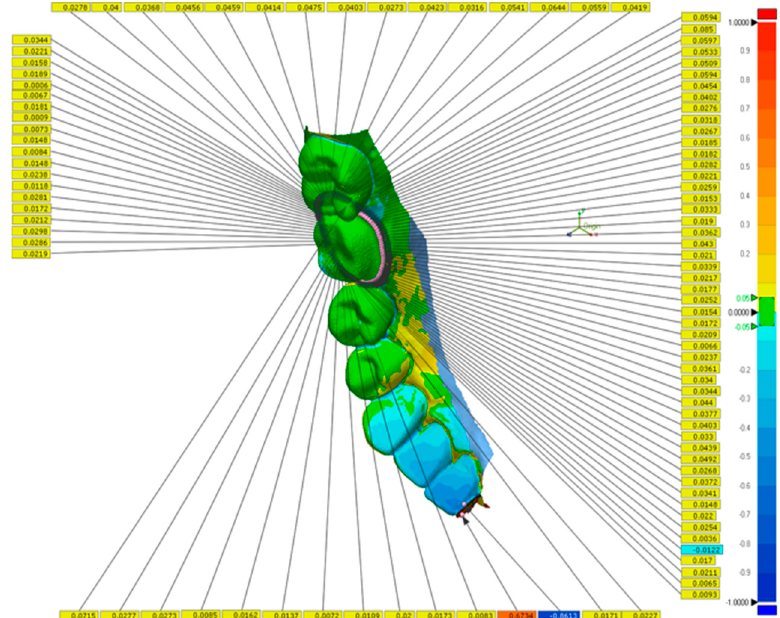
Figure 3. Deviation between master scan and intraoral scan measured at 100 evenly spaced points along the preparation finish line. The specific values of deviation along the finish line are given in yellow legends. The range of deviation across the entire half-arch scan is color graded from − 1 mm (blue) to + 1 mm (red).